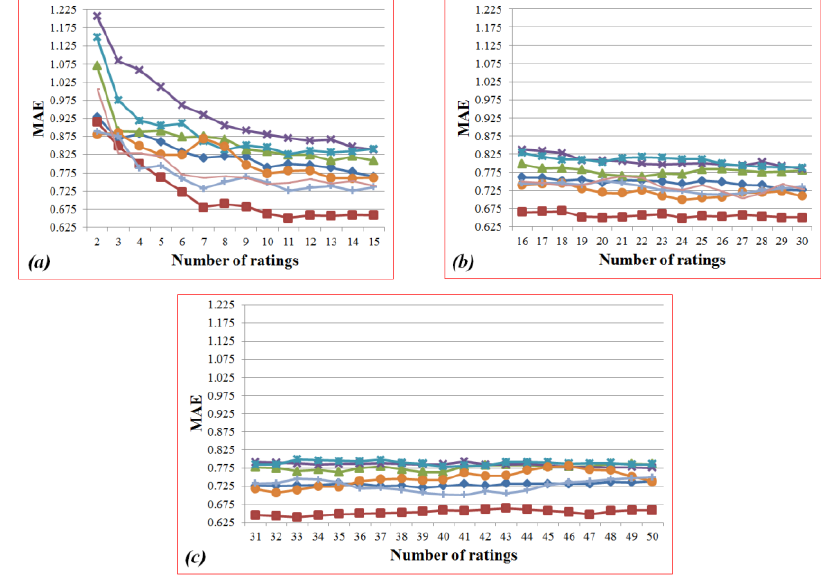
Figure 27. MAE values for the different numbers of ratings based on the Pearson correlation coefficient in the item-based filtering.